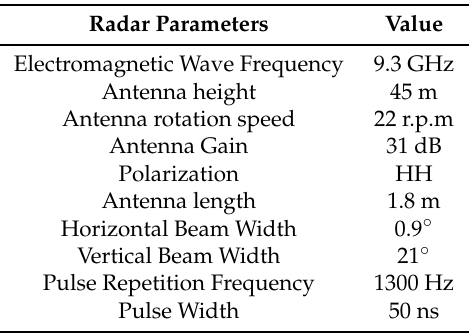
Table 1. The parameters of X-band marine